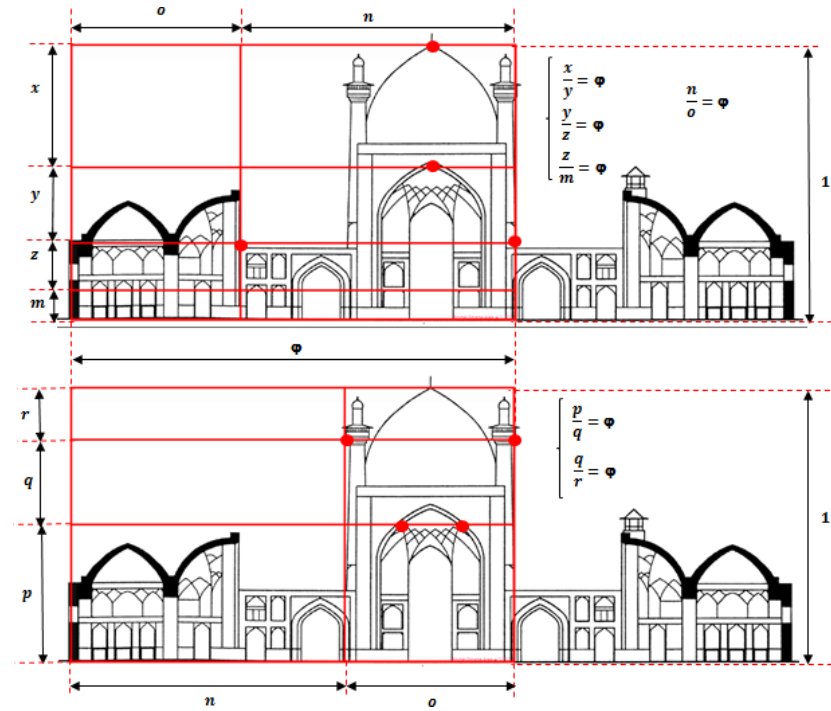
Figure 13: Abstract frame between two finials (left-side of east-west section) adapt with golden rectangle